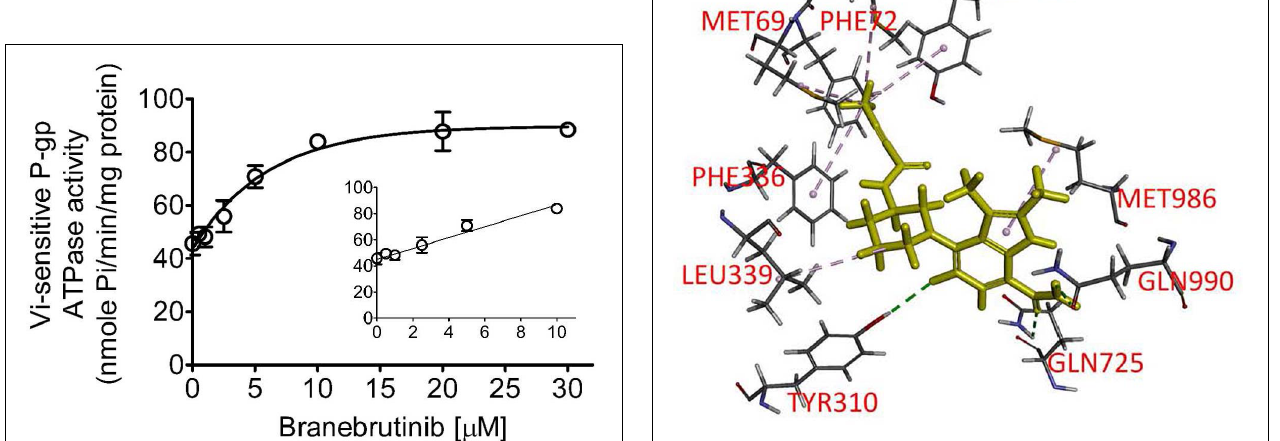
FIGURE 5 | Branebrutinib stimulates the ATPase activity of P-glycoprotein (P-gp). The effect of 0–30 µ M of branebrutinib (0–10 µ M, inset) on P-gp-mediated ATP hydrolysis was measured in the membrane vesicles prepared from High-Five insect cells overexpressing human P-gp and recorded as vanadate (Vi)-sensitive ATPase activity as previously described (Wu et al., 2013). Points, mean from at least three independent experiments; bars, SD.